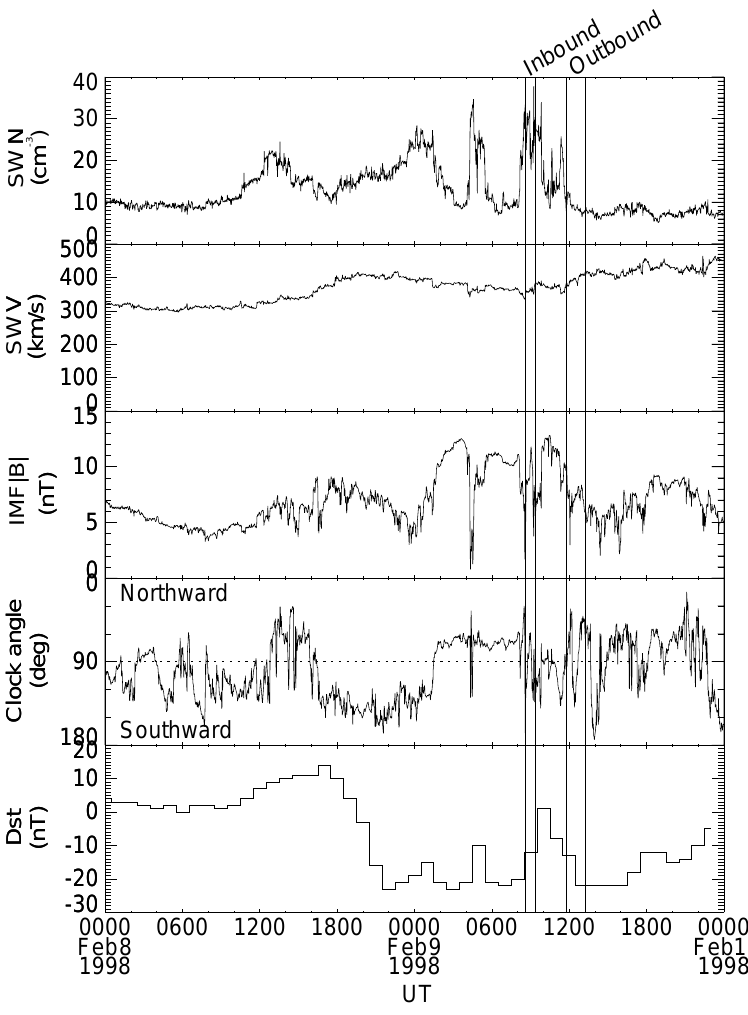
Fig. 2. From top to bottom, the solar wind density (SW N), the solar wind velocity (SW V), the intensity of the IMF (IMF B), the clock angle of IMF and D st on 8–9 February